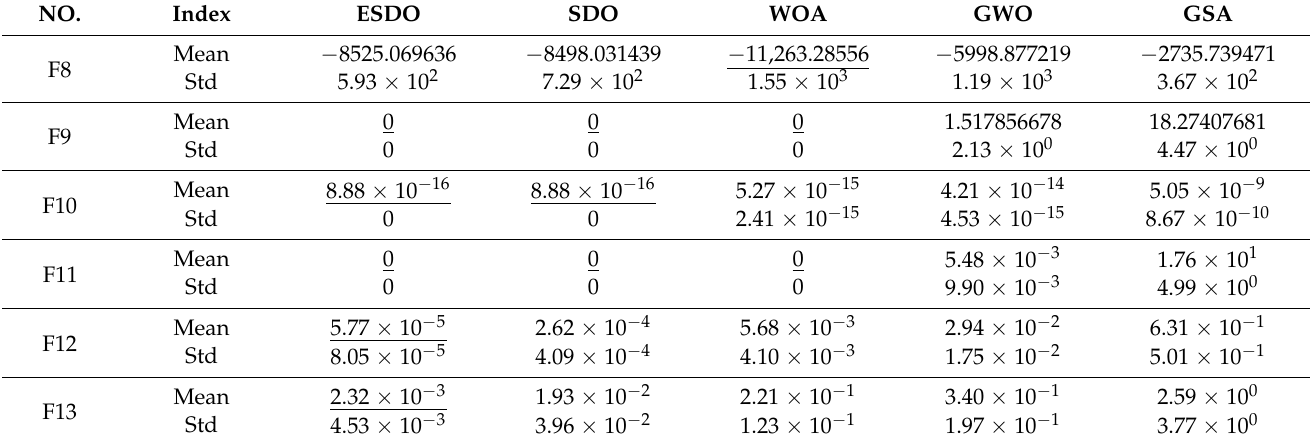
Table 3. Comparison results of MNs (F8–F13).